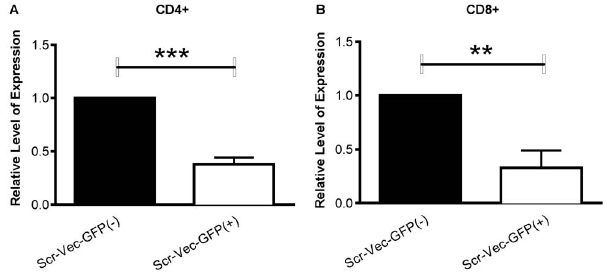
Figure 4. CD25 expression levels by RT-PCR. RNA was isolated from CD4 + (A) and CD8 + (B) populations from six donors following 20 hours activation with anti-CD3/anti-CD28. Relative CD25 expression levels were normalized to beta-actin, calculated using the 2-(delta- delta(CT)) method and compared by Student’s paired t-test. Mean and SEM are shown and P # 0.05 was considered to be